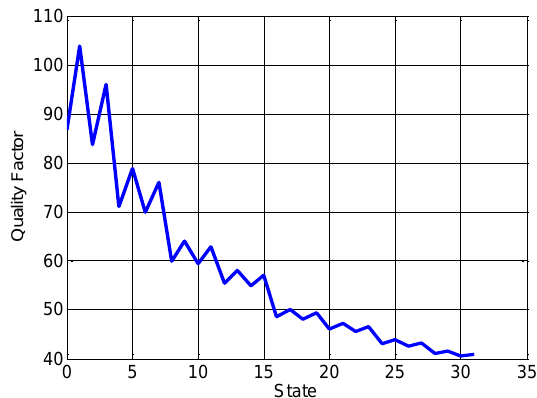
Figure. 3. Simulated quality factor (@1 GHz) vs